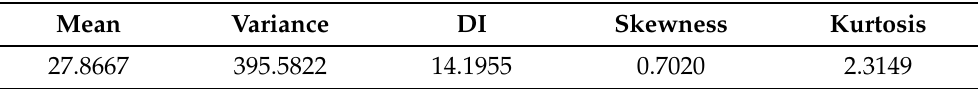
Table 10. Values of some descriptive statistics of the DPsL distribution for the failure times